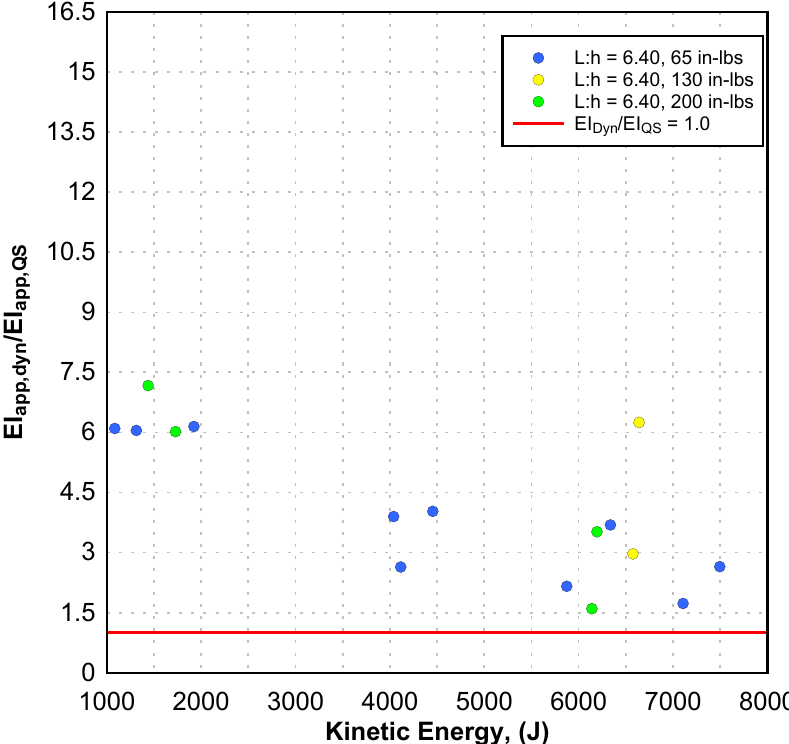
Figure 17. Dynamic Apparent stiffness ratio for five-laminae